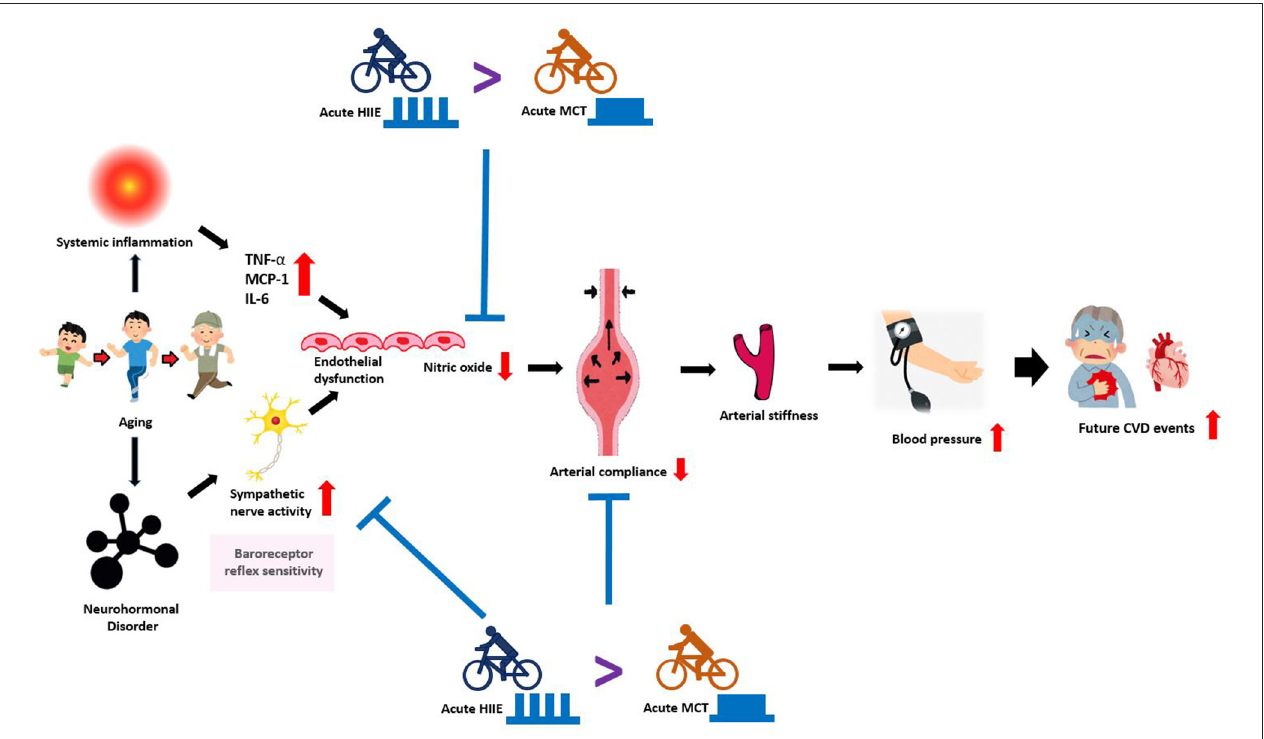
FIGURE 1 | An overview of the mechanisms mediating age-related vascular dysfunction and how HIIT and MCT can improve vascular function by decreasing sympathetic nerve activity. With advancing age, several adverse changes occur in the arterial system that drives the development of CVD. Aging is associated with reduced baroreceptor reflex sensitivity (sympathetic nervous activity) and endothelial dysfunction, marked by reduced nitric oxide and increased inflammatory mediators (TNF- α , MCP-1, IL-6, etc.). Together, these processes induce vascular dysfunction, featuring: neurohormonal disorder, reduced arterial compliance, increased arterial stiffness that drives the development of high blood pressure, which also increases the risk for future cardiovascular events. In agreement with scientific evidence, both HIIT and MCT training improves vascular dysfunction by reducing sympathetic nervous activity and increasing nitric oxide. In contrast, HIIT is more efficacious for improving vascular function and increasing baroreceptor reflex sensitivity than MCT. HIIT: high-intensity interval training; MCT: moderate continuous training CVD: cardiovascular disease; TNF- α : tumor necrosis factor- α ; MCP-1: monocyte chemoattractant protein-1; IL-6: